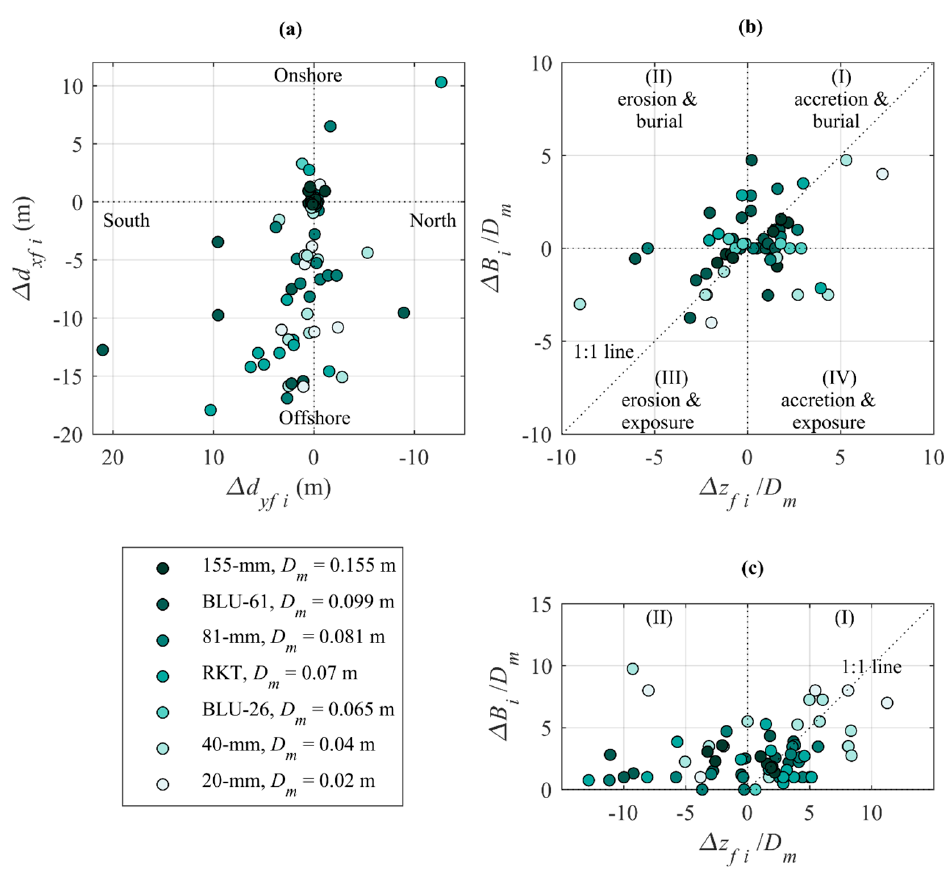
Figure 15. Long term deployed munitions observations. ( a ) Migration distances in x f and y f from initial ( x f ,y f ) position. ( b , c ) Rate of change of the dimensionless burial depth as a function of the rate of change of the dimensionless beach morphology change for munitions that remained in place ( b ) or moved ( c ). Migration distances and rate of change of burial depth of each symbol are evaluated as the difference between the position or the burial depth between adjacent surveys. The color scheme is associated with munition diameter with darker colors for larger munition calibers.